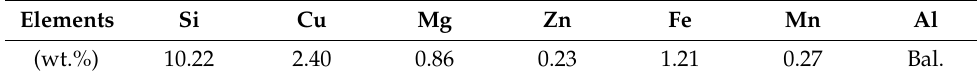
Table 1. Composition of A380